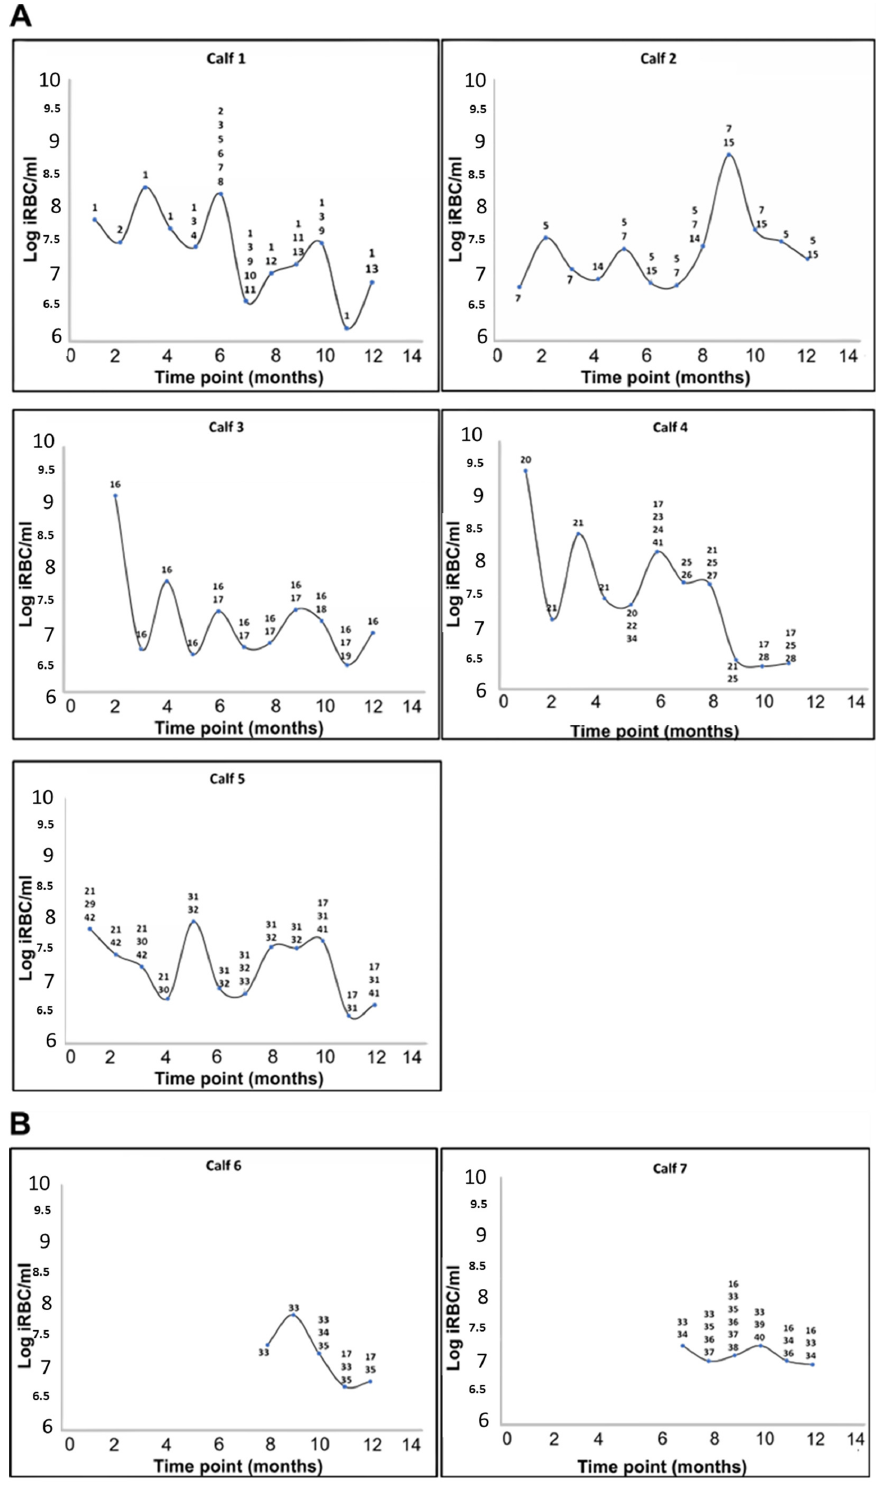
Figure 3. Cyclic A. marginale rickettsaemia in calves from the Mnisi community as determined by qPCR [25,34]. The level of infection is expressed as the log of infected red blood cells (RBC) per mL (iRBC/mL) of blood. ( A ) Calves infected with A. marginale at the peri-urban area. ( B ) Calves infected with A. marginale at the wildlife–livestock interface. The number and type of A. marginale msp1 α genotypes detected at each time-point are indicated for each calf; genotypes were assigned numbers as shown in Table